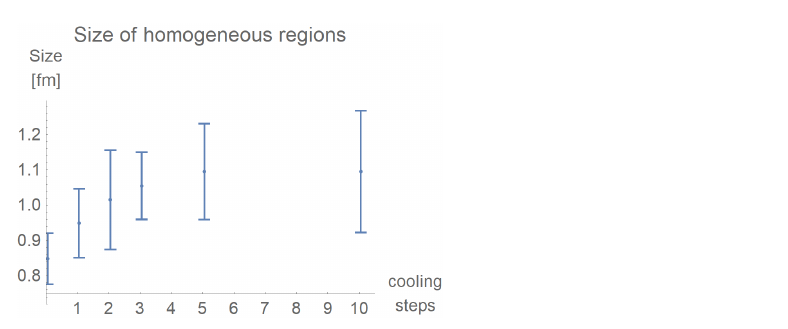
Figure 19. Estimated size of color-homogeneous regions after five cooling steps. The error bars are to be considered with care.